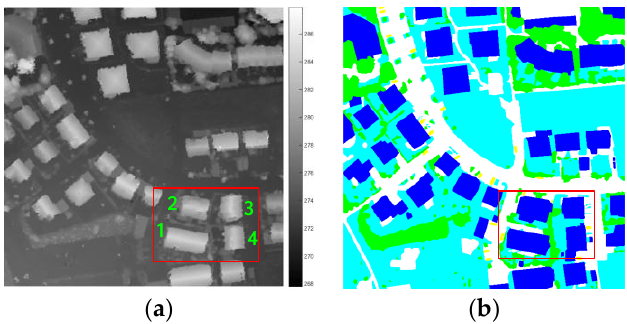
Figure 10. Dataset 1: ( a ) original DSM shown as image, and 1, 2, 3 and 4 is the serial number of the four buildings; ( b ) ground truths.